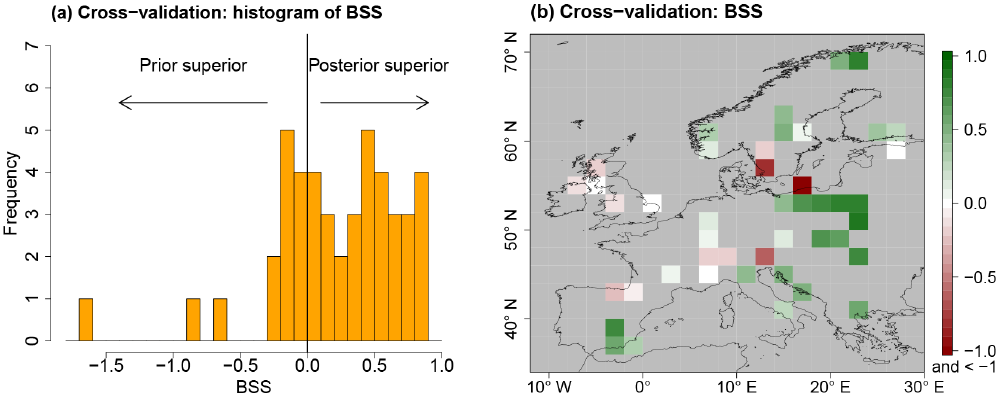
Figure 9. BSS from leave-one-out cross-validation: (a) histogram, (b) spatial